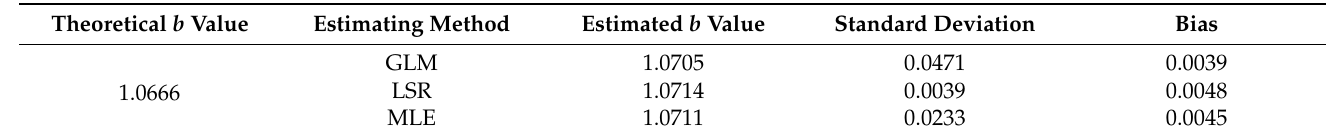
Table 2. Parameter settings of AE device.